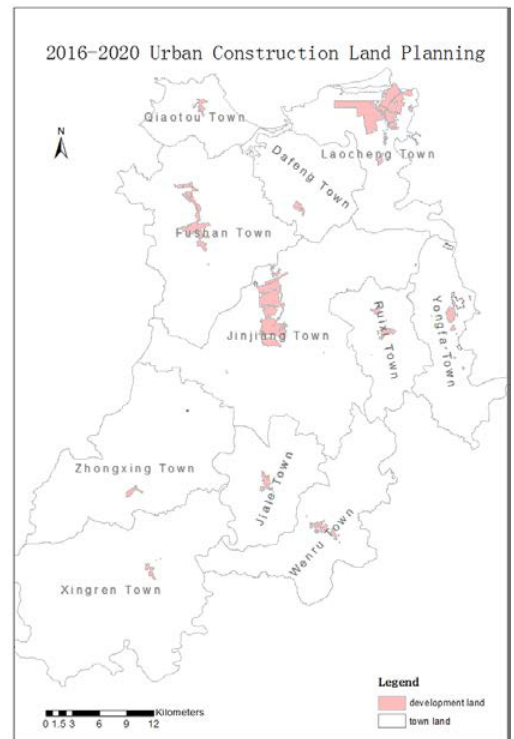
Figure 3. Distribution of urban construction in Chengmai Figure 4. Distribution of urban construction in